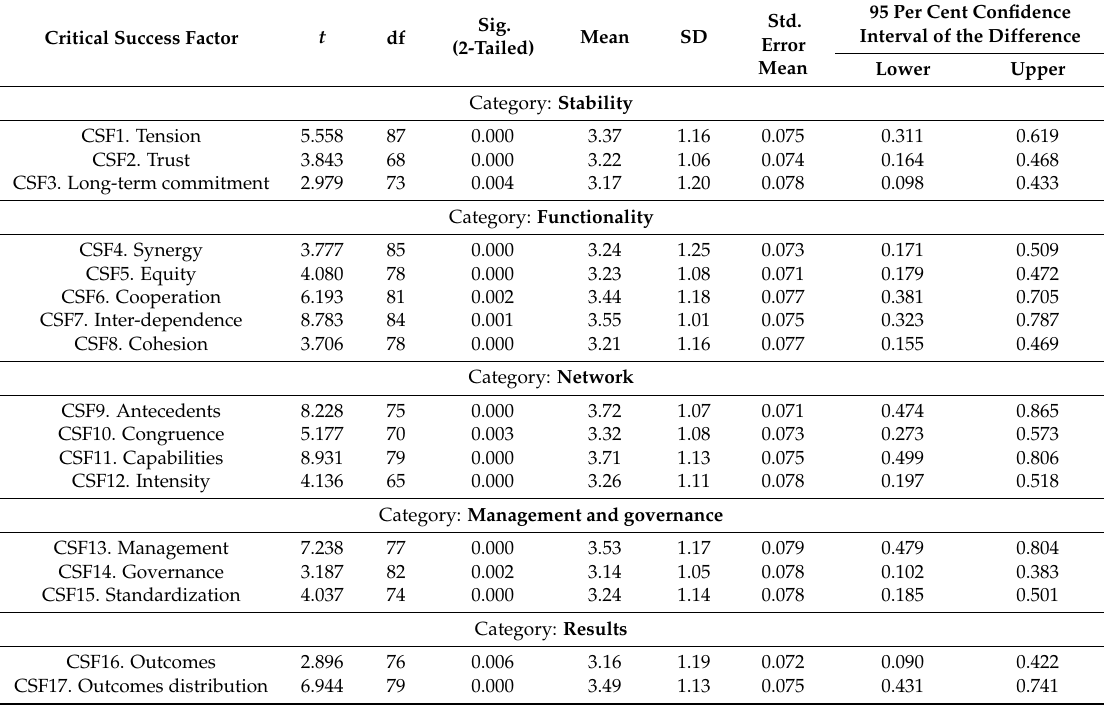
Table 5. Critical Success Factors t -test.